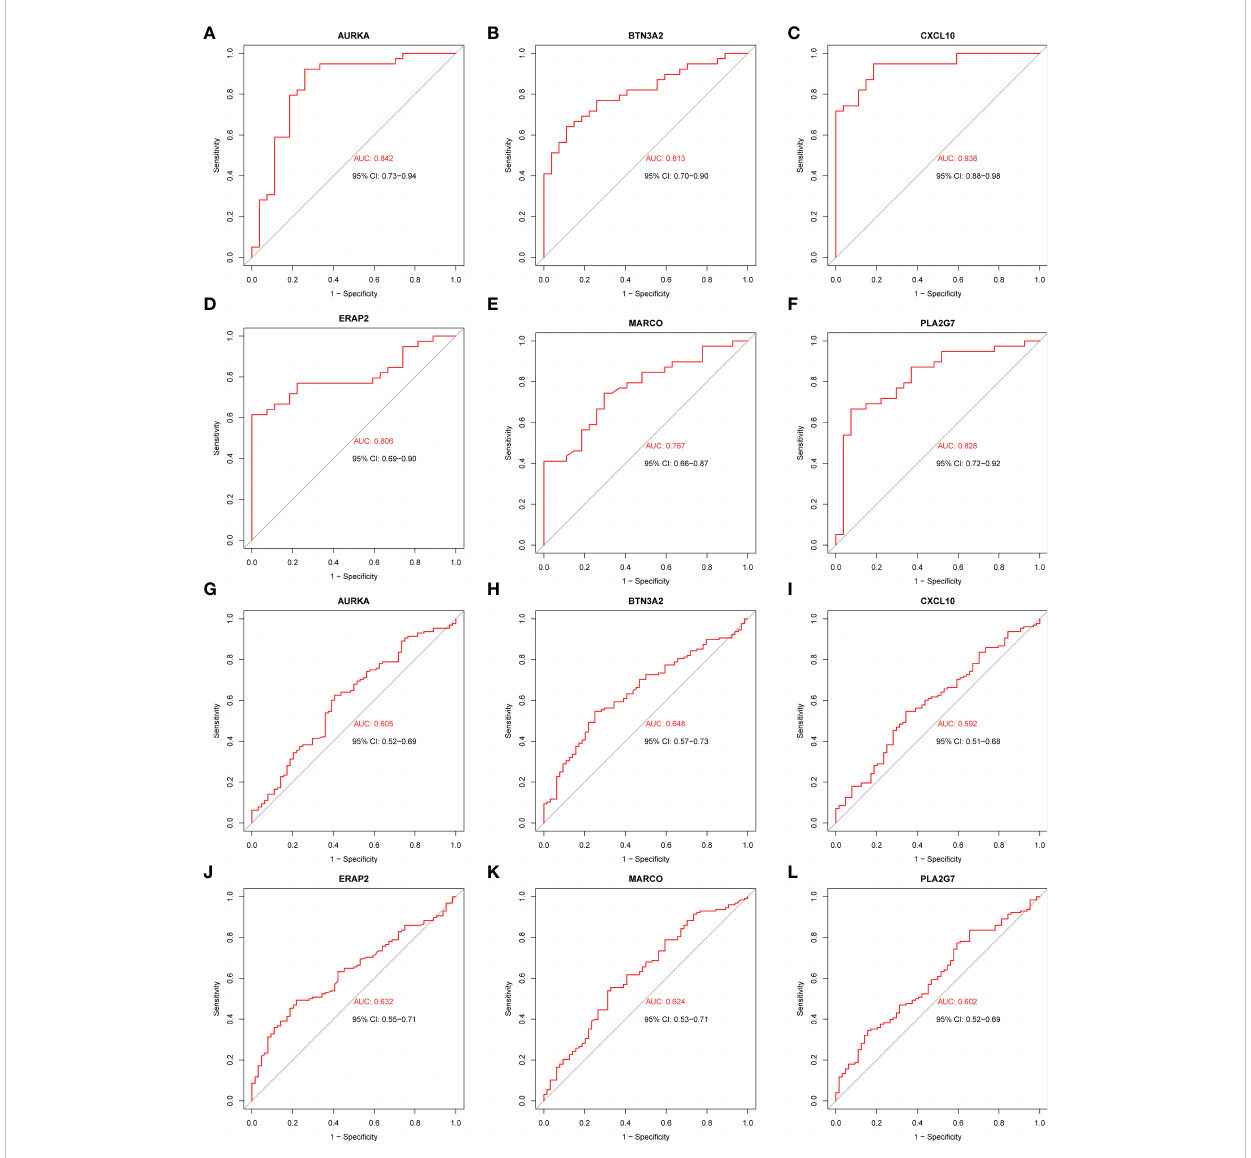
FIGURE 7 ROC curves of the 6 common core genes in RA and MDD. (A, B, C, D, E, F) ROC curves of AURKA , BTN3A2 , CXCL10 , ERAP2 , MARCO , PLA2G7 in the RA dataset, respectively. (G, H, I, J, K, L) ROC curves of AURKA , BTN3A2 , CXCL10 , ERAP2 , MARCO , PLA2G7 in the MDD dataset,